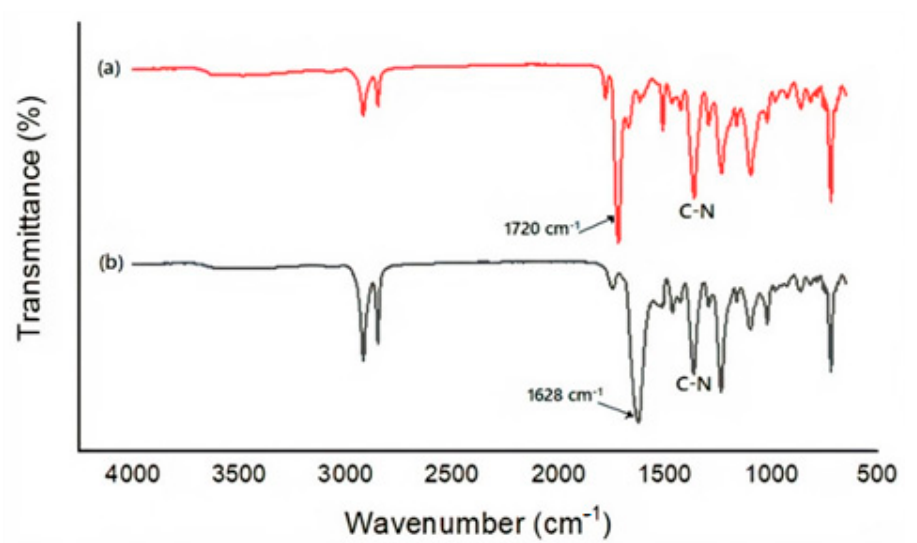
Figure 5. FT-IR for the nanofiber before the adsorption process ( a ) and after the adsorption process ( b ).